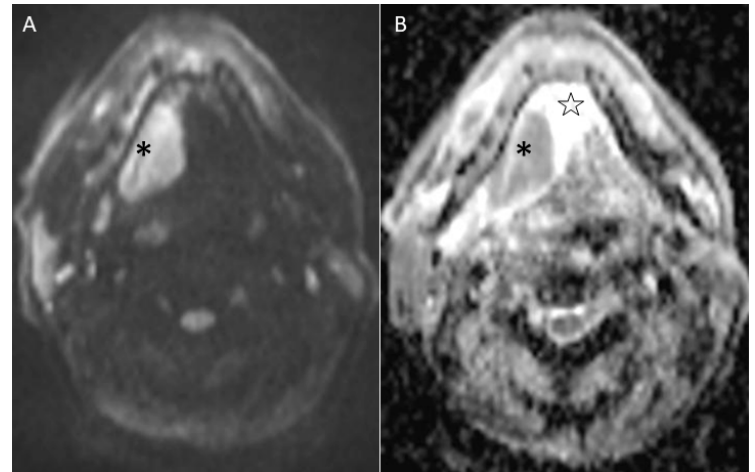
Figure 6. Squamous cell carcinoma of the mouth floor. ( A ) DWI trace (b = 1000). The neoplasm shows high signal (*). ( B ) ADC map. Low ADC values of the neoplasm (*, 1.08 × 10 − 3 mm 2 /s), whereas the surrounding inflammatory tissue shows high ADC values (star, 2.3 × 10 − 3 mm 2 /s).